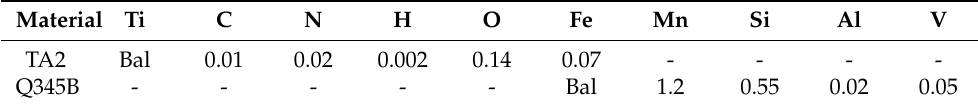
Table 1. Chemical composition of the base and clad materials (mass fraction) %.